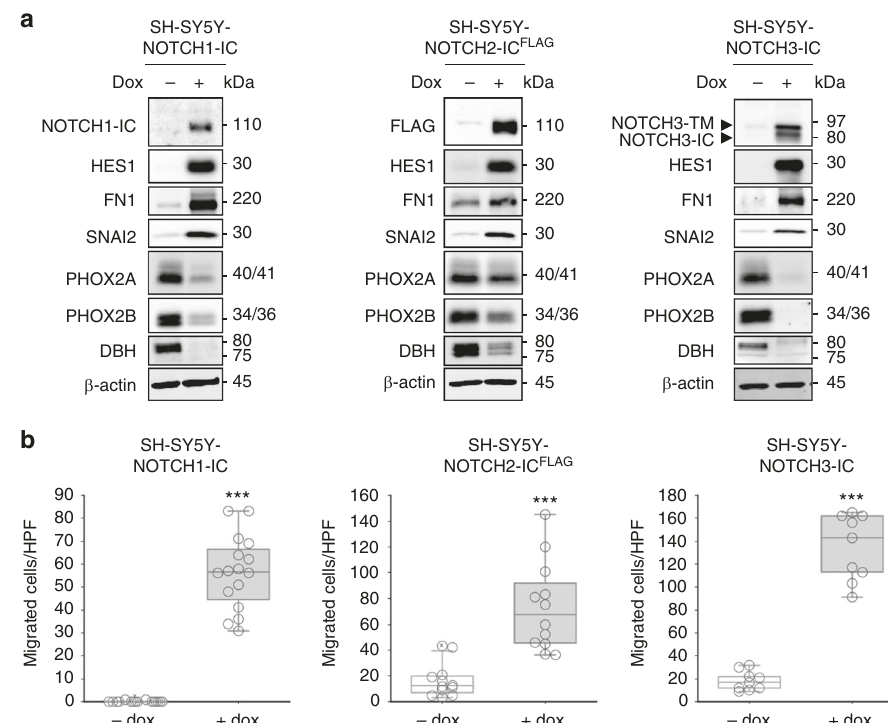
Fig. 2 NOTCH paralogues induce a mesenchymal phenotype in ADRN neuroblastoma cells. a Western blot analysis of cell lysates of SH-SY5Y with inducible overexpression of NOTCH1-IC, NOTCH2-IC FLAG or NOTCH3-IC. Immunoblots show NOTCH1-IC, NOTCH2-IC FLAG or NOTCH3 proteins as well as protein of the known NOTCH target gene HES1 to con fi rm induction of each transgene. Lysates are analyzed for MES-markers (FN1 and SNAI2) and ADRN-markers (PHOX2A, PHOX2B, and DBH). β -actin was used as loading control. IC intracellular domain, TM transmembrane domain, dox